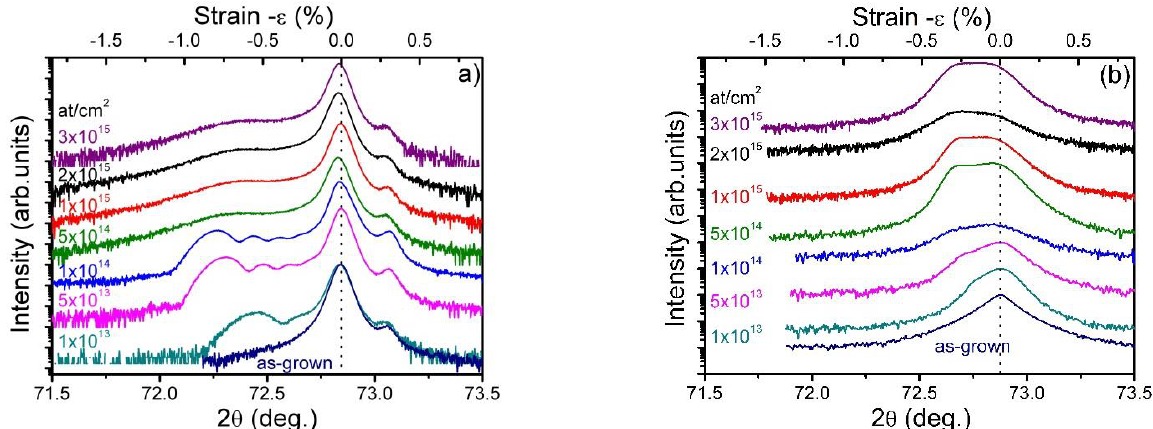
Figure 5. X − ray diffraction 2 θ − θ scans ( θ being the Bragg angle) of the 0004 reflection of c-plane GaN thin films ( a ) and GaN NWs ( b ) before and after implantation with different Eu fluences at 300 keV and 20 ◦ incident angle. The dotted line marks the main Bragg peak corresponding to the unimplanted volume of the crystal. Note that the small peak at 2 θ = 73.05 ◦ is due to residual K α 2 radiation that was not completely removed by the monochromator. Reprinted with permission from Ref. [45].